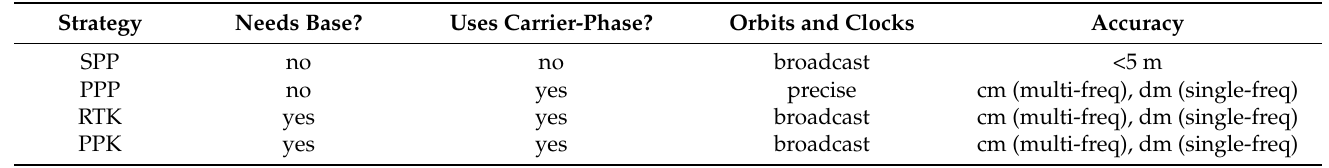
Table 3. Features of several GNSS strategies [42].